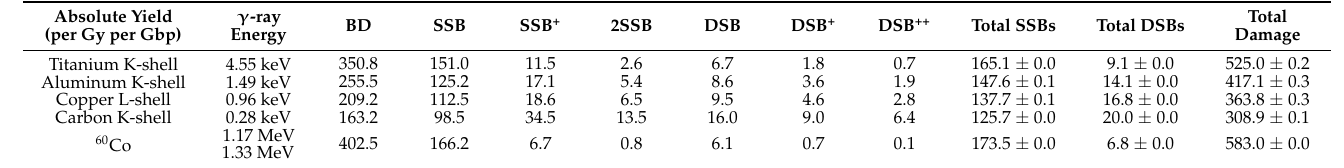
Table 3. Absolute yields of DNA damage (per Gy per Gbp) induced by ultrasoft X-rays and 60 Co γ -rays under moderate hypoxia (2%).